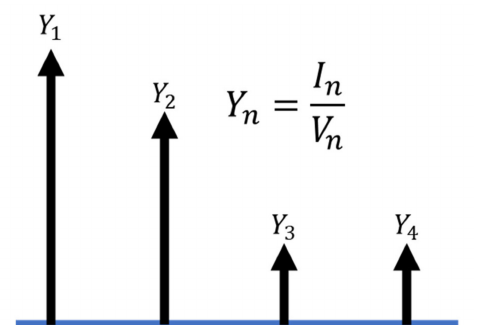
Figure 11. Admittance normalizing the current by grid effects, equating all harmonics and leaving only the grid internal characteristics. If V 1 is 100 times stronger, it does not matter for the Y 1 , Y 2 ratio.